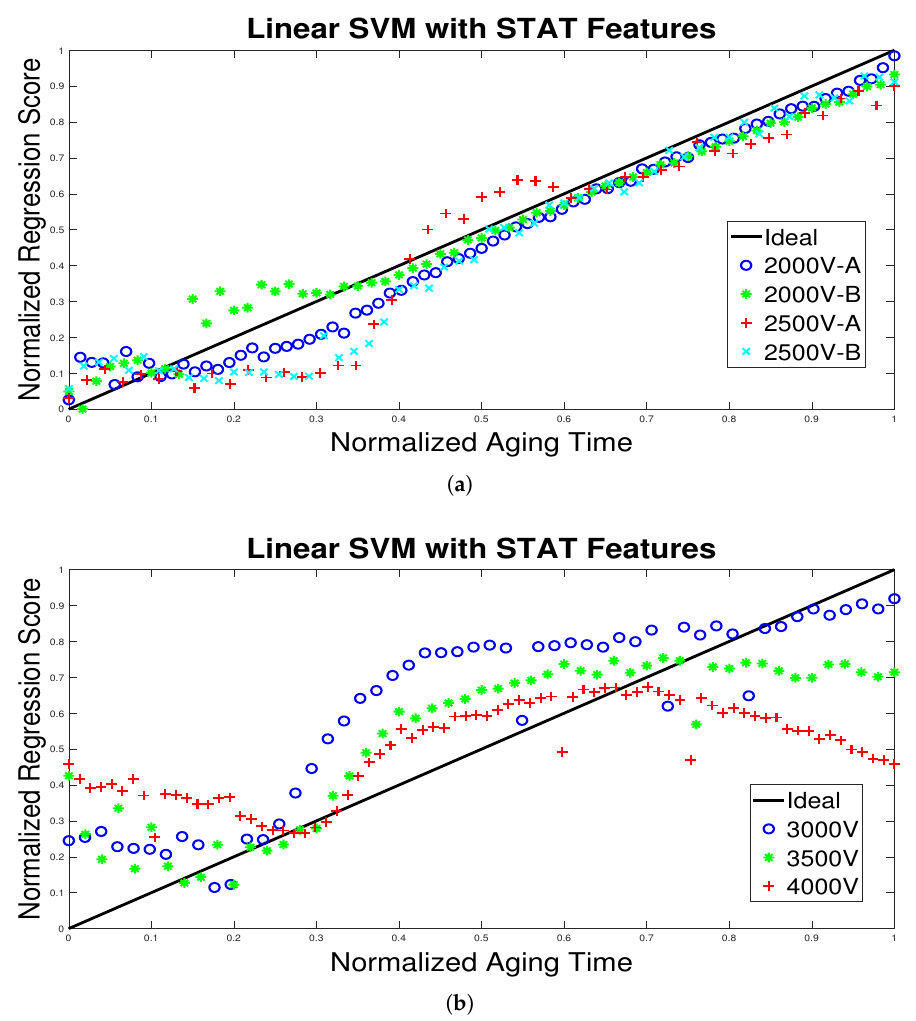
Figure 7. Linear SVM results with STAT features with a power supply in the range [ 2000 2500 ] V ( a ) and in the range [ 3000 4000 ] V ( b